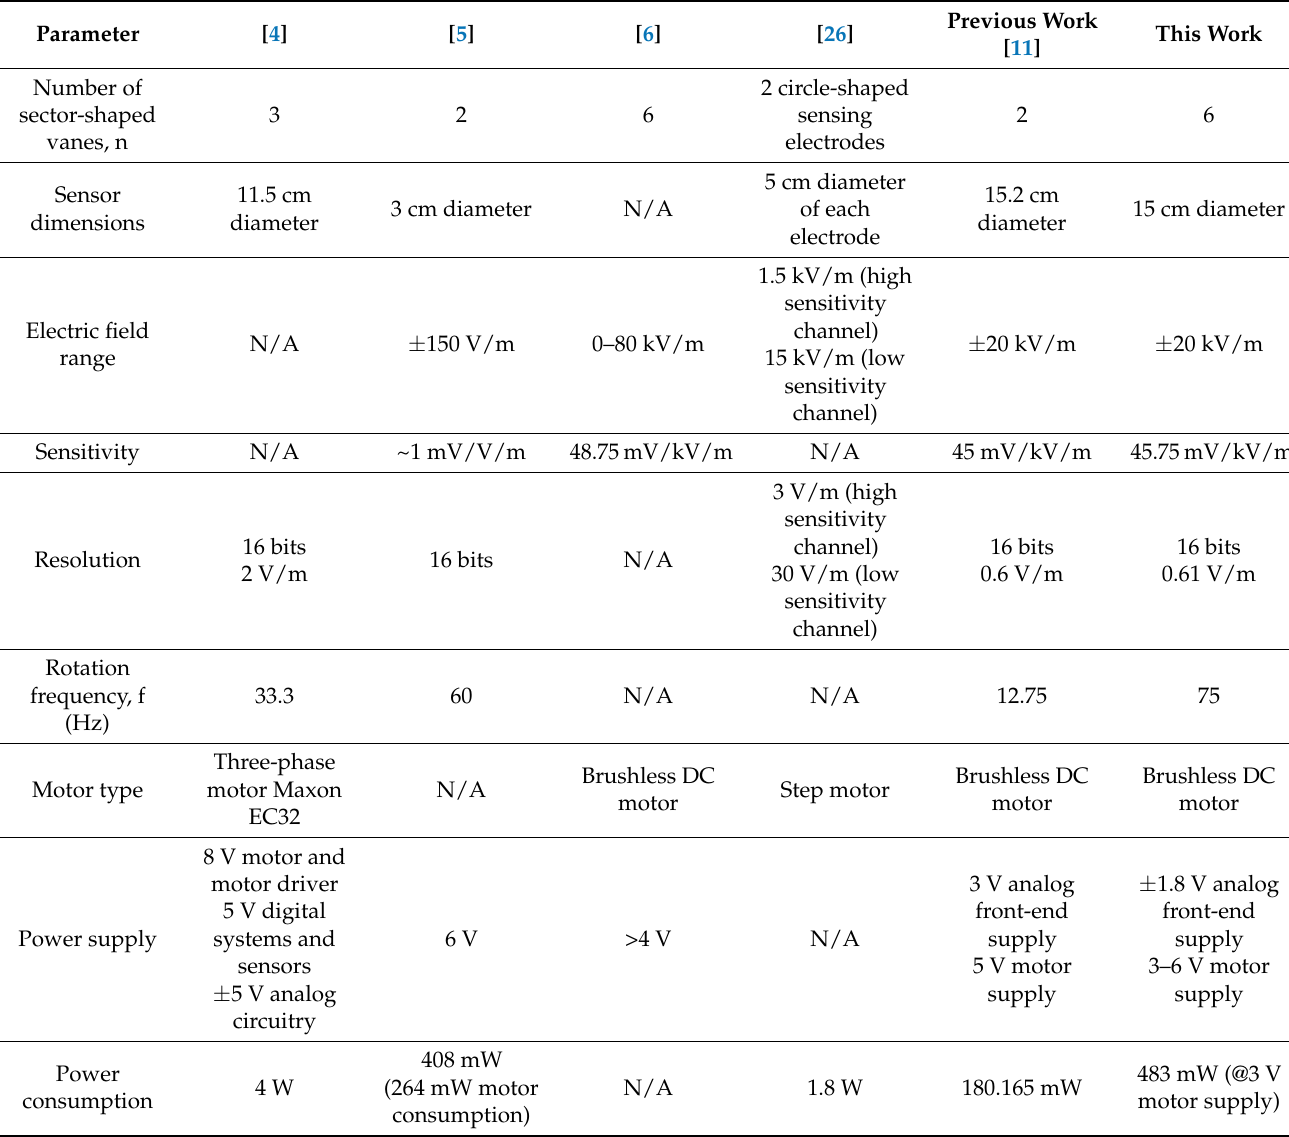
Table 22. Table of comparison of electric field mill analog front-end systems in the